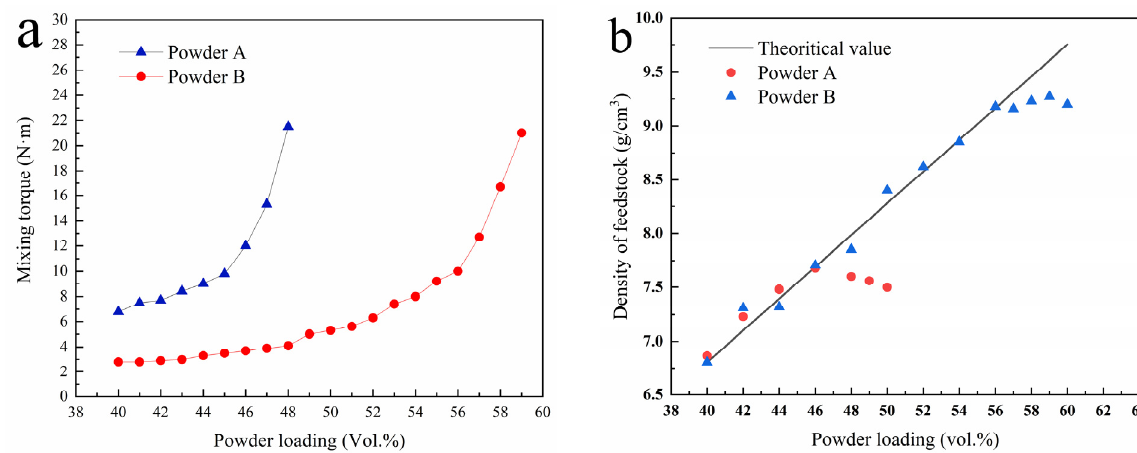
Figure 4. ( a ) Mixing torque of feedstock variation with the powder loading; ( b ) density of feedstock variation with the powder loading.